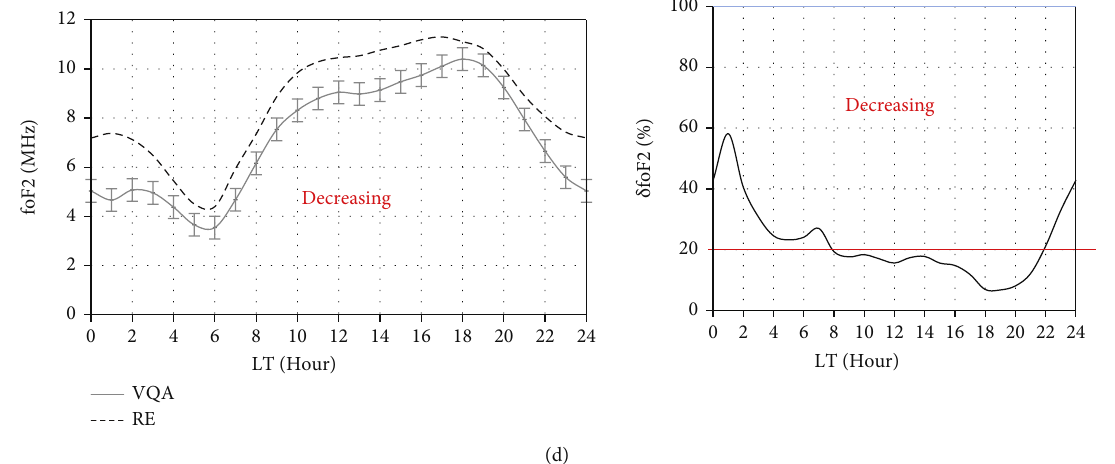
Figure 3: Solar phases ’ in fl uence on foF2 diurnal variations during recurrent events